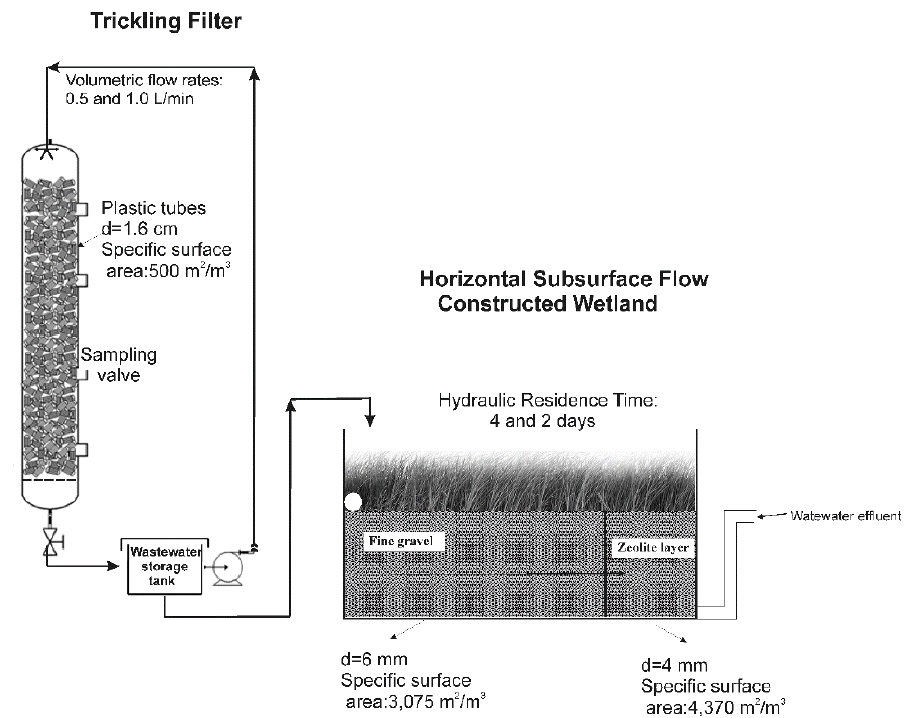
Figure 1. Scheme of the hybrid system the combining biological trickling filter and constructed wetland for the treatment of winery wastewater.